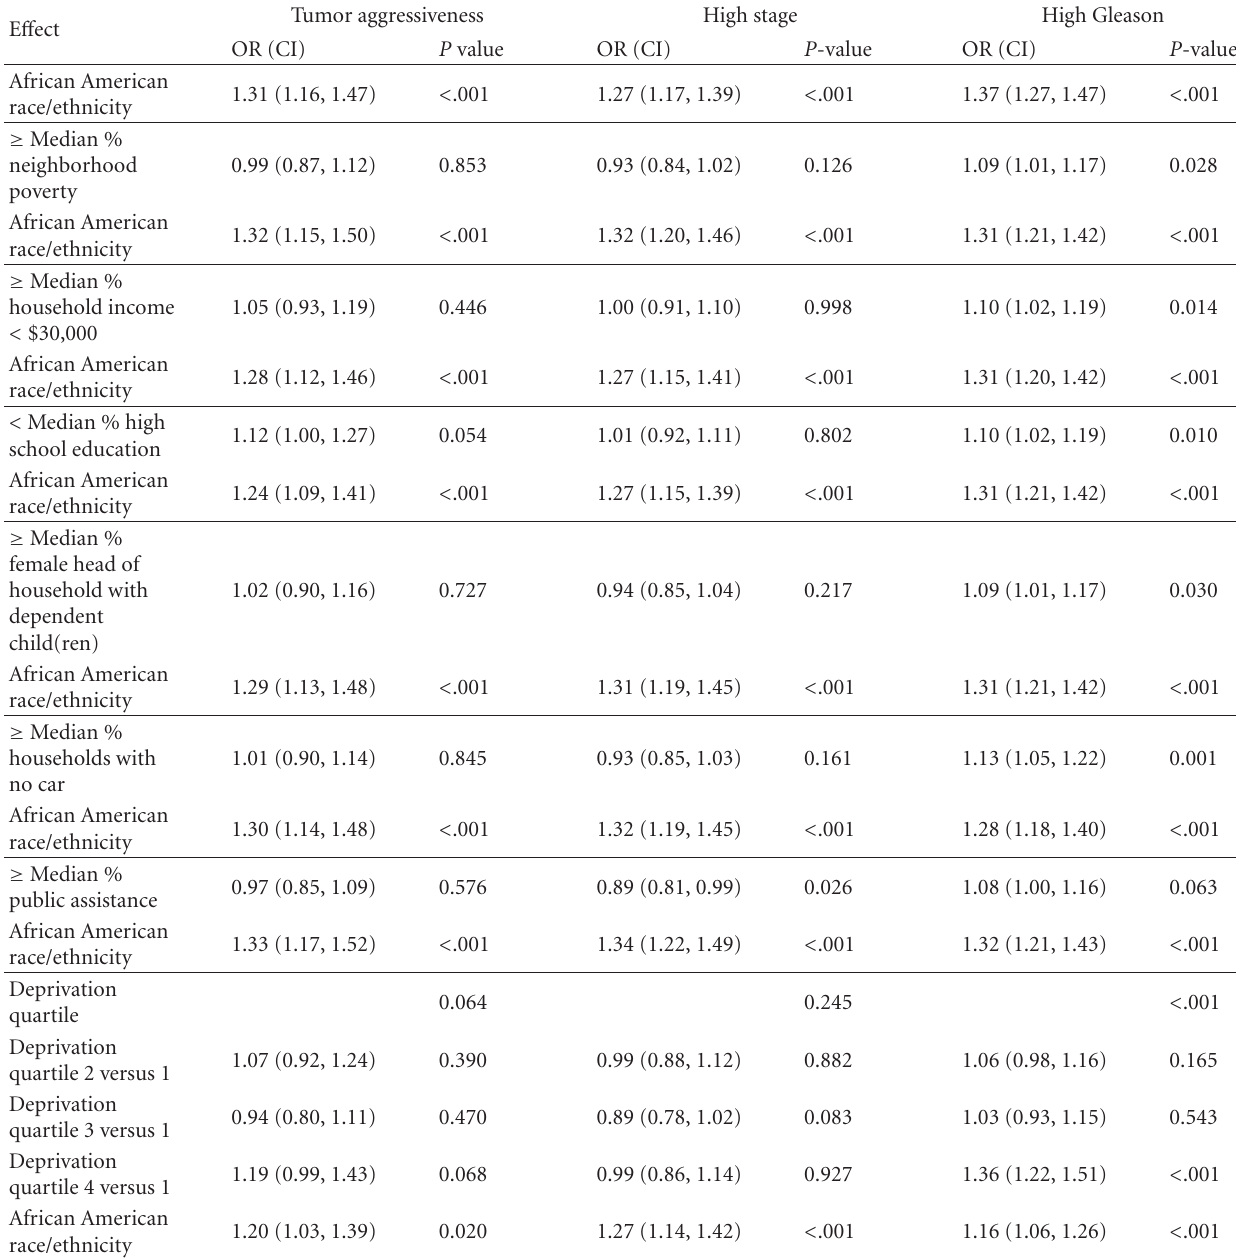
Table 3: Unstratified analysis—associations of neighborhood SES characteristics with indicators of prostate cancer severity (GEE) adjusted for age, race, and diagnosis